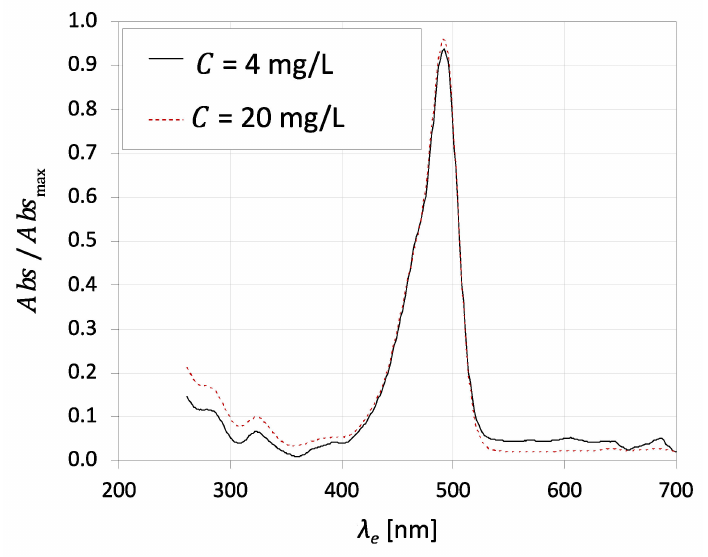
Figure 2. Absorption spectra of fluorescein for an excitation wavelength from 200 to 700 nm for 4 mg · L − 1 and 20 mg · L − 1 in H 3 PO 4 0.100 M + NaOH 0.165 M medium, pH =